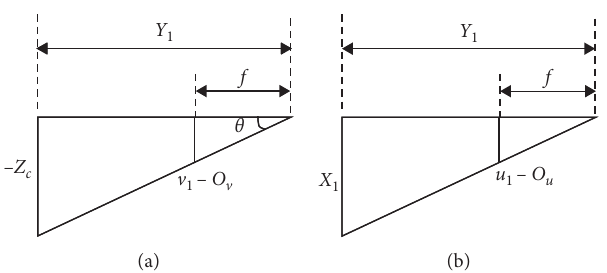
Figure 5: Relationship between a lane endpoint in the camera coordinate system and the corresponding point in the image coordinate system. (a) similarity in triangles for Y